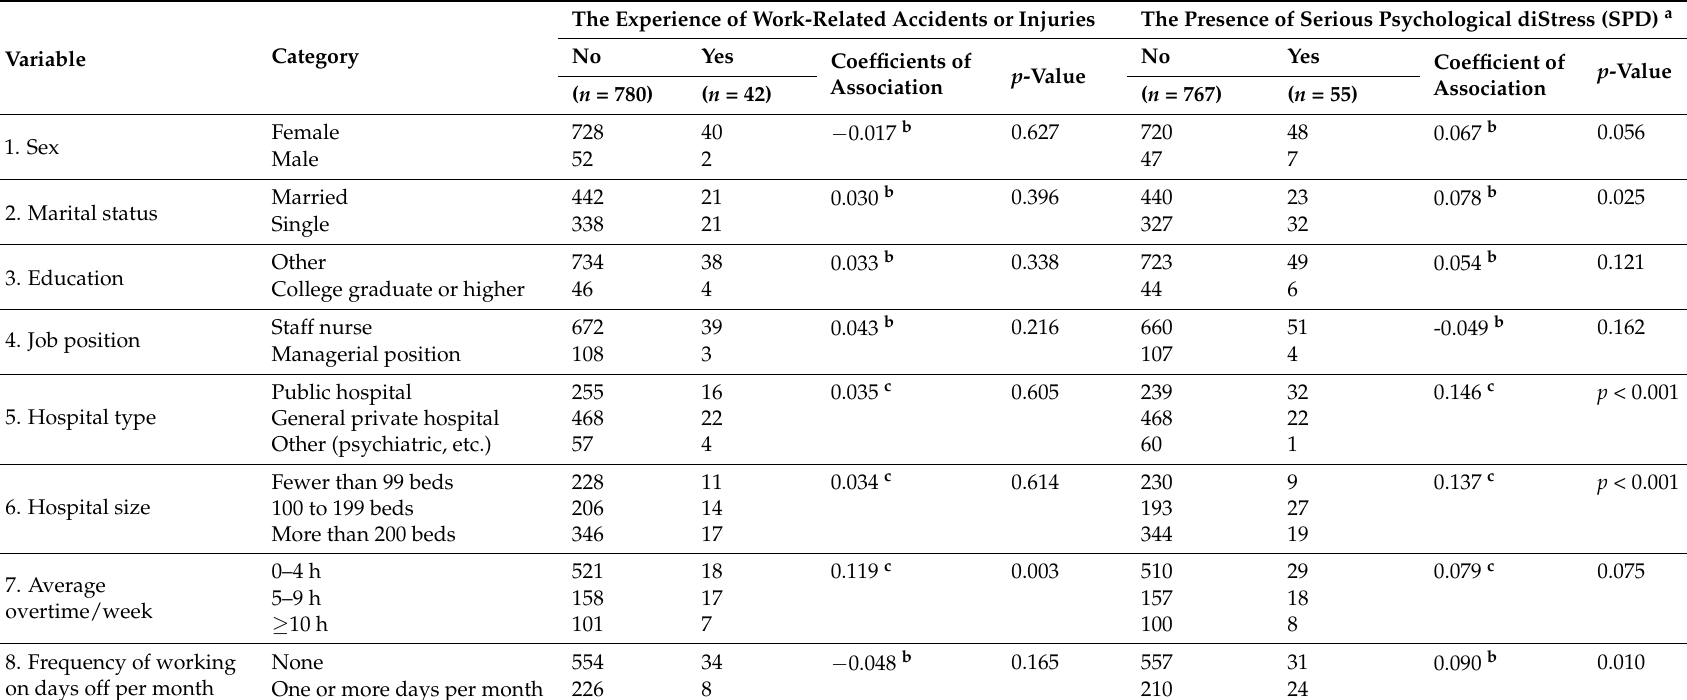
Table 3. The association between dependent variables and participants’ basic characteristics ( n =